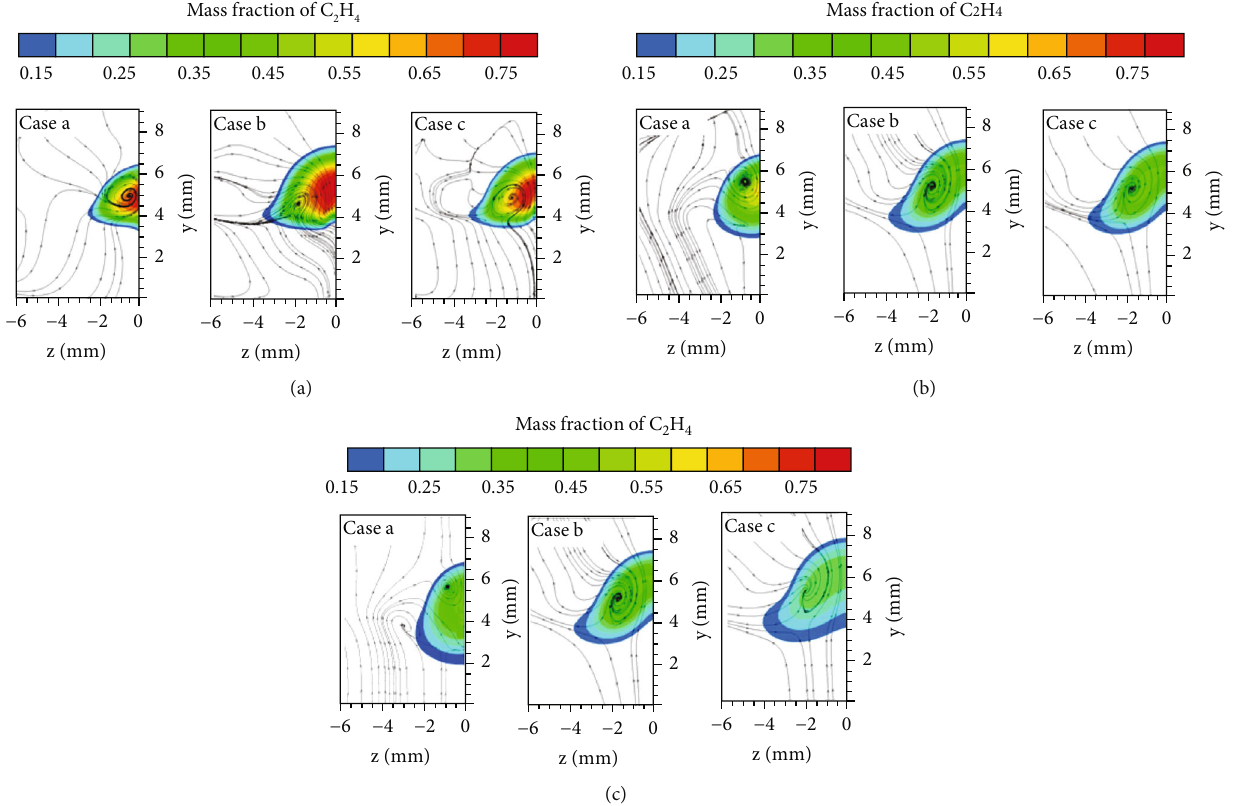
Figure 8: Mass fraction contours of the ethylene component and the streamlines at x = 70 , 75, and 80mm for case A, case B, and case C. (a) x = 70mm . (b) x = 75mm . (c) x = 80 mm .